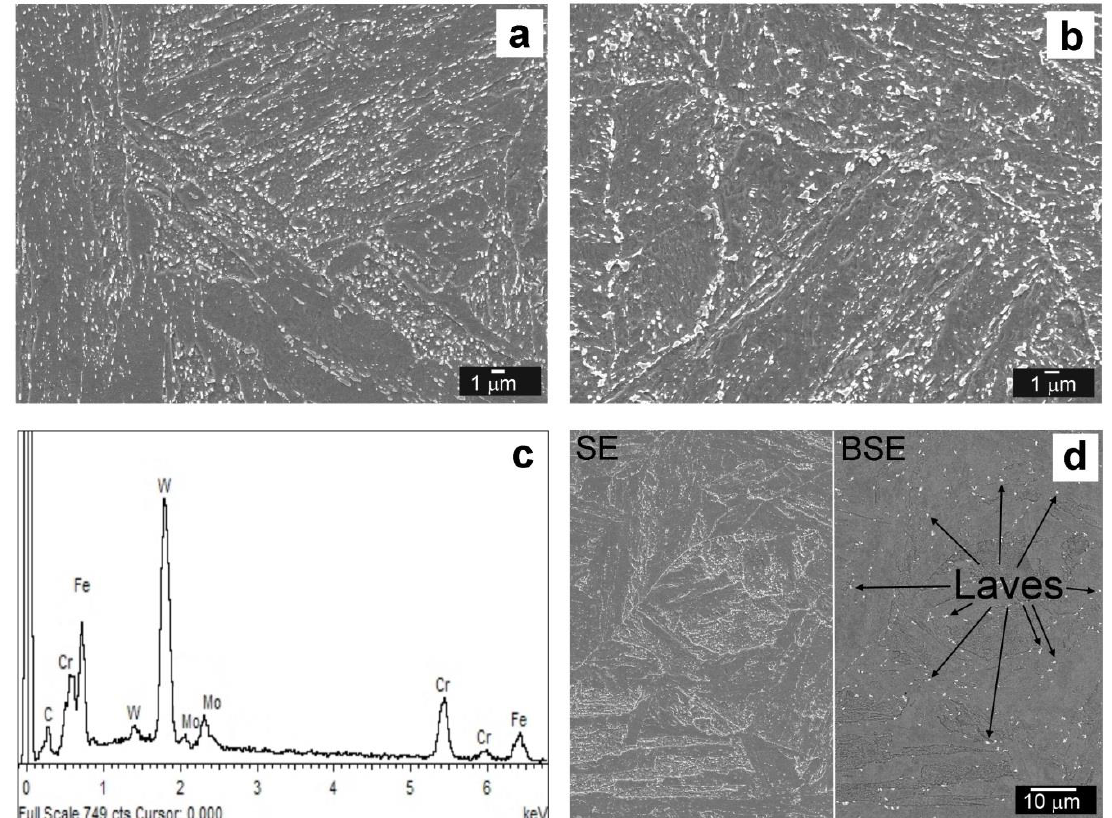
Figure 3. Microstructural characterization of the T92 base material (BM) region in different material states: QT PWHT ( a ); QT PWHT + 620 °C/2500 h ( b ) with typical EDX spectrum of Fe 2 (W,Mo) based Laves phase precipitates ( c ) and distribution of coarse Laves phase particles visualized in secondary electrons (SE) mode and back-scattered electrons (BSE) mode ( d ).